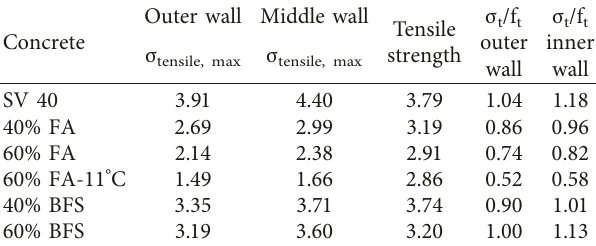
Table 9: Calculated stress/strength ratios at inner and outer walls at 14days.